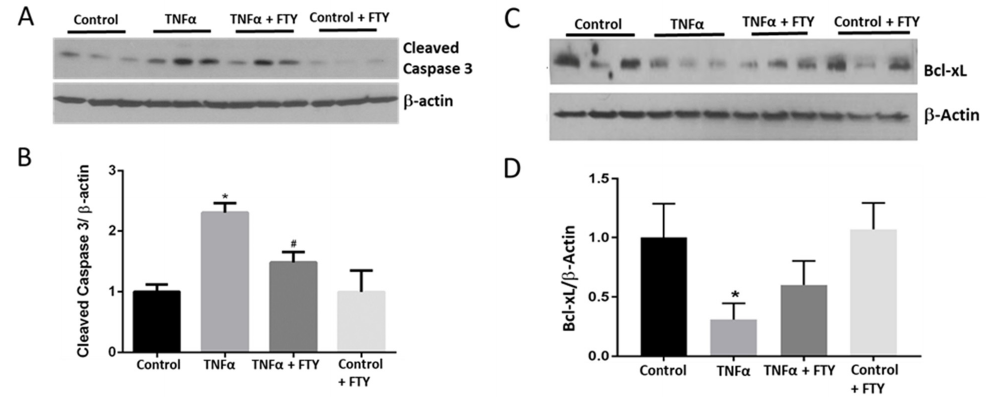
Figure 3. Fingolimod co-treatment blunted TNF α -induced activation of cleaved caspase-3 and expression of Bcl-xL. ( A ) Representative Western blot data showing increased expression of cleaved caspase-3 with TNF α treatment, which was reduced in the presence of FTY. ( B ) Bar graph showing band densitometry quantification indicating increased cleaved caspase-3 expression with TNF α treatment [* p < 0.05 vs. Con; n = 3] and its reversal by co-treatment with FTY [* p < 0.005 vs. control; # p < 0.05 vs. TNF α ; n = 4]. ( C ) Western blot images showing reduced expression of Bcl-xL with TNF α treatment, which was increased in the presence of FTY. ( D ) Bar graph showing band densitometry quantification of Western blots indicating reduced Bcl-xL expression with TNF α treatment [* p < 0.05, n = 3]. The changes observed in response to FTY, however, were not statistically